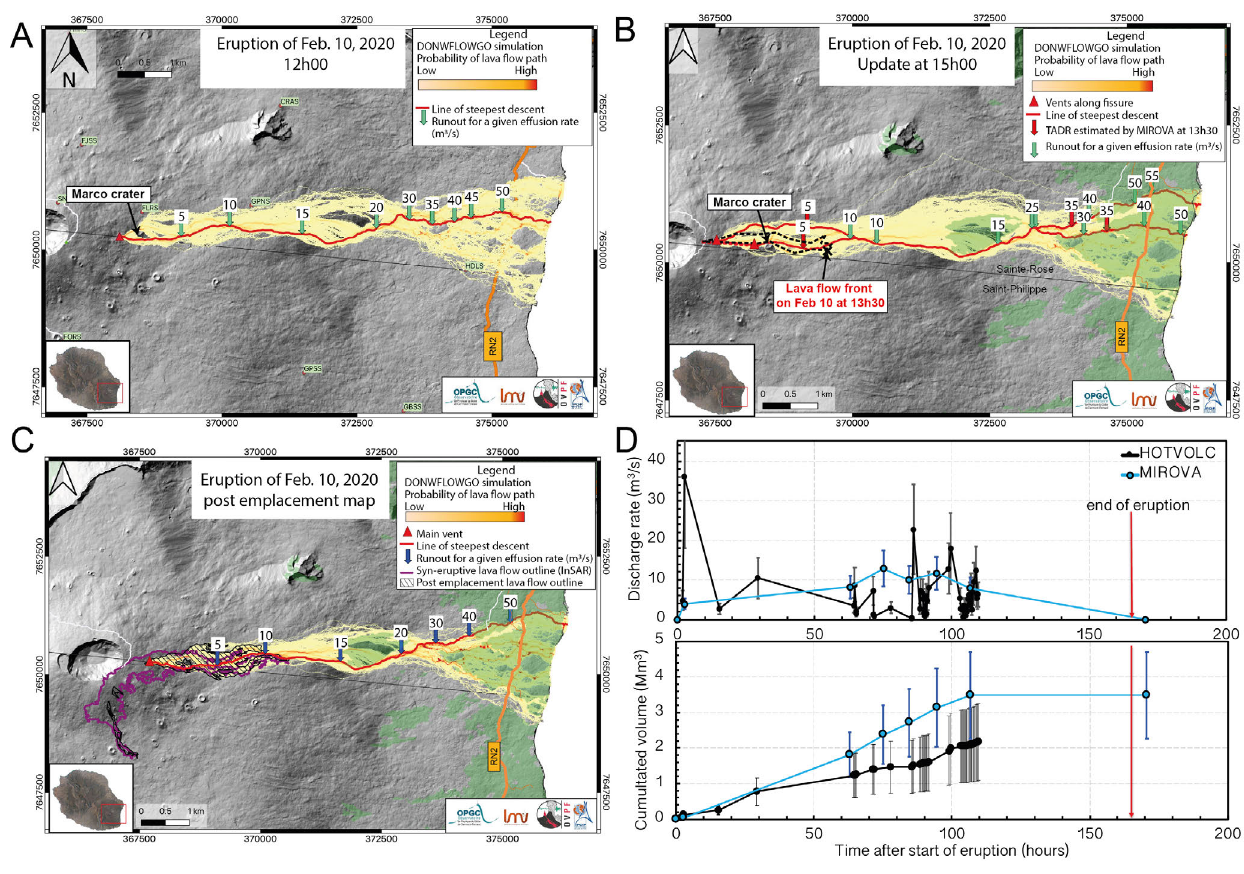
Figure 5: [A] First map produced on 10 February, 2020 at 12:00 RET. Note that the color code for the lava flow inundation probability is now from light yellow to red (see Section 6 for the reason of the change). [B] Updated map produced on 10 February, 2020 at 16:00 with the precise location of the vent. This map shows two simulations, one from the highest elevation of the fissure and one from the lowest. Green arrows show the location of the lava runout along the LoSD for given discharge rates (numbers are in m 3 s − 1 ) and red arrows locate the TADR obtained from MIROVA (5 m 3 s − 1 ) and from HOTVOLC (35 m 3 s − 1 ). Dashed black line represent the lava flow outline obtained from MODIS image with the front location as observed at 13:30. [C] Final map showing the probability of lava flow invasion from the main vent (as identified after the end of the eruption), the syn-eruptive lava flow outline obtained on 11 February, 2020 using InSAR data and the final outline obtained by photogrammetry. This final map was produced after the end of the eruption and is an updated version of the one published in the OVPF monthly report of February 2020 [OVPF 2020]. [D] Lava discharge rate and cumulative volume since the start of the eruption obtained by HOTVOLC and MIROVA